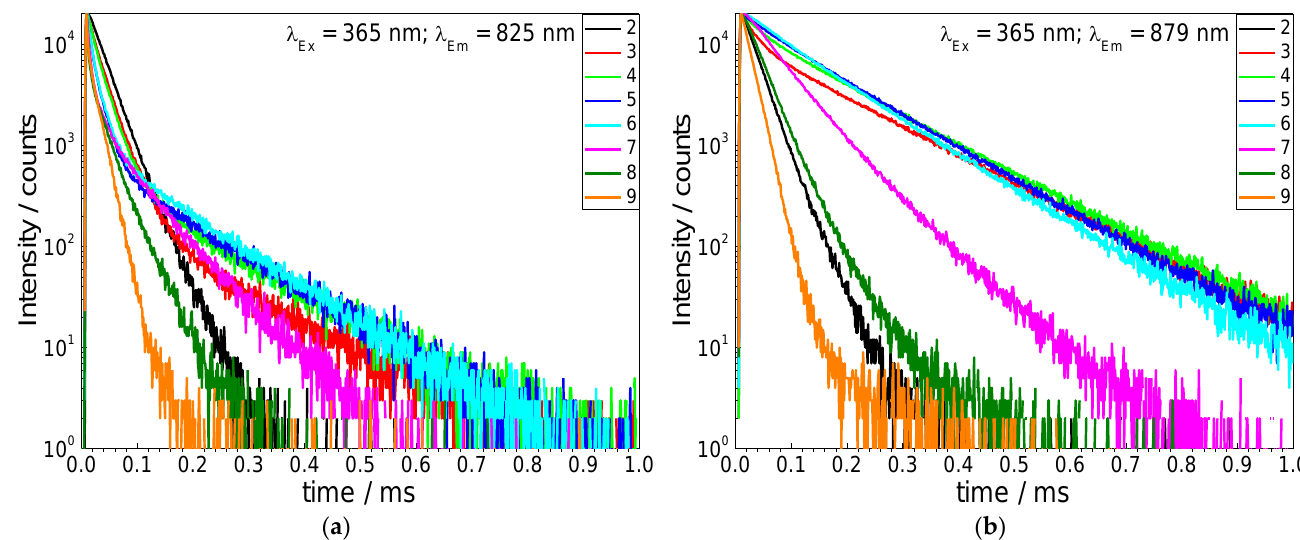
Figure 5. Decay curves of Ca 2 MgWO 6 doped with 1% Cr 3+ and (0 – 8)% Nd 3+ and double amount of Li + and Na + ; ( a ) emission monochromator fixed at emission line of Cr 3+ (825 nm), ( b ) emission monochromator fixed at emission line of Nd 3+ (879 nm).